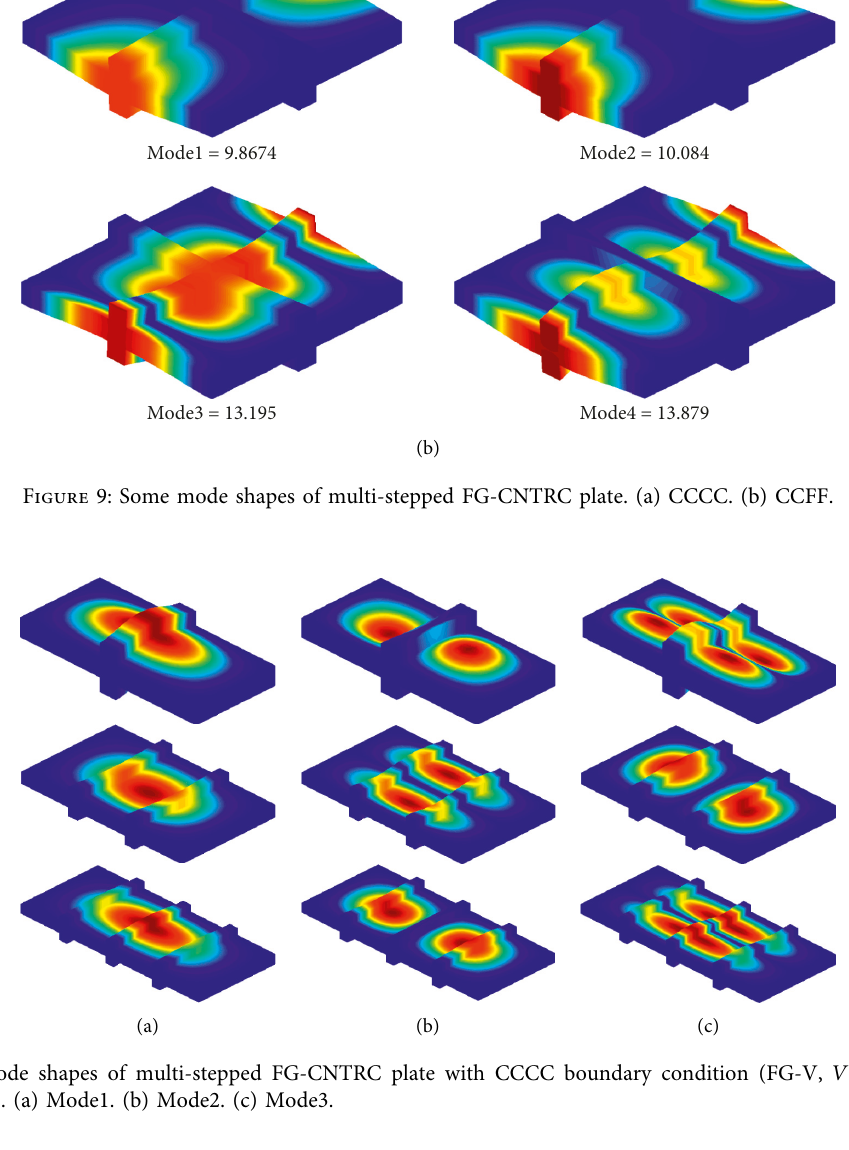
� 0 . 28, η 1 =0.141, CNT